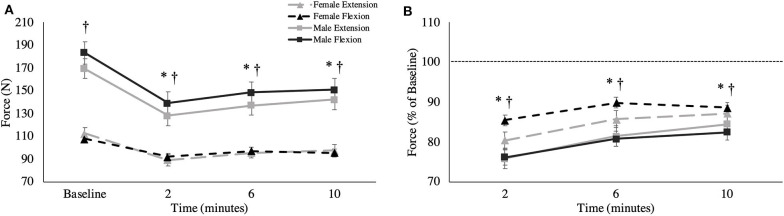
(A) Absolute MVC force (newtons) and (B) relative MVC force across all time points. This is shown as group averages (with standard error bars). The data is separated by sex and muscle group. † = data are significantly different between sexes; * = pooled data are significantly different from baseline.